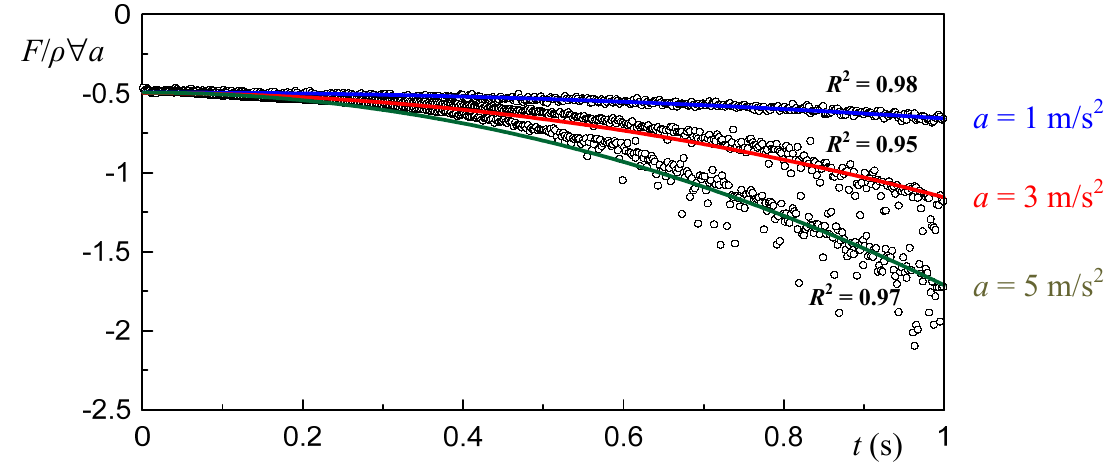
Figure 10. Variation of the external force F ( t ) within the 1 s interval with different linear acceleration a .